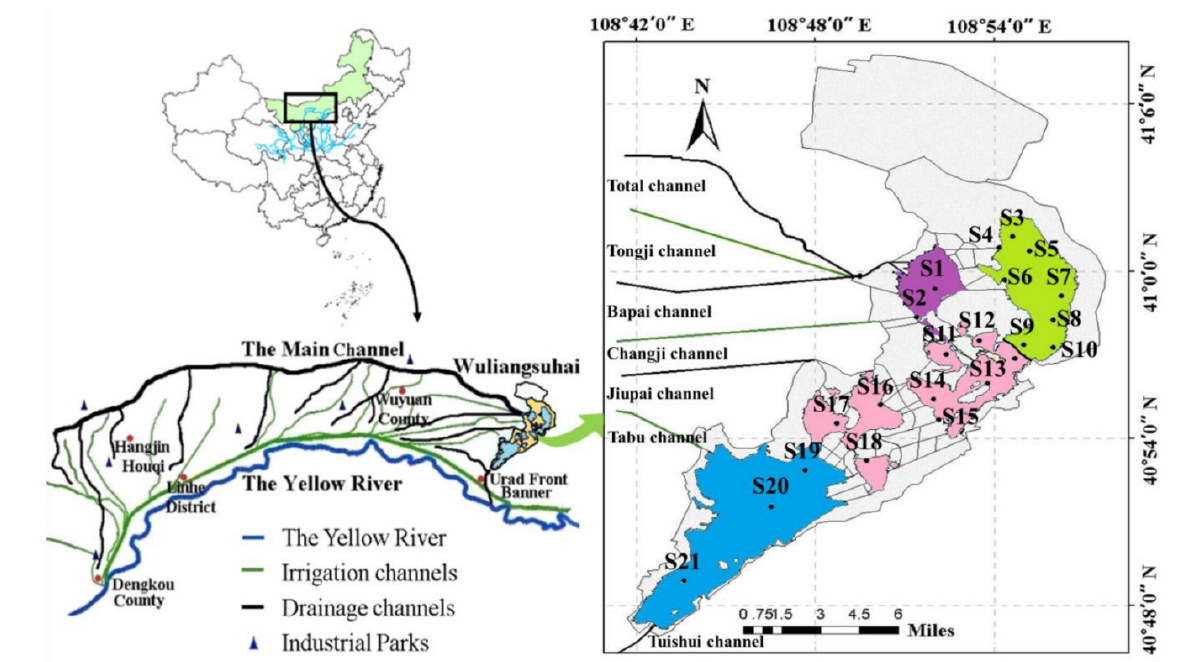
Figure 1. Location of the Wuliangsuhai wetland in Hetao Irrigation District, China. (The data sets of the Wuliangsuhai wetland and Hetao irrigation system are modified from Google Earth; the data set of Chinese Map is provided by Data Center for Resources and Environmental Sciences, Chinese Academy of Sciences (http://www.resdc.cn, accessed on 25 January 2019)).